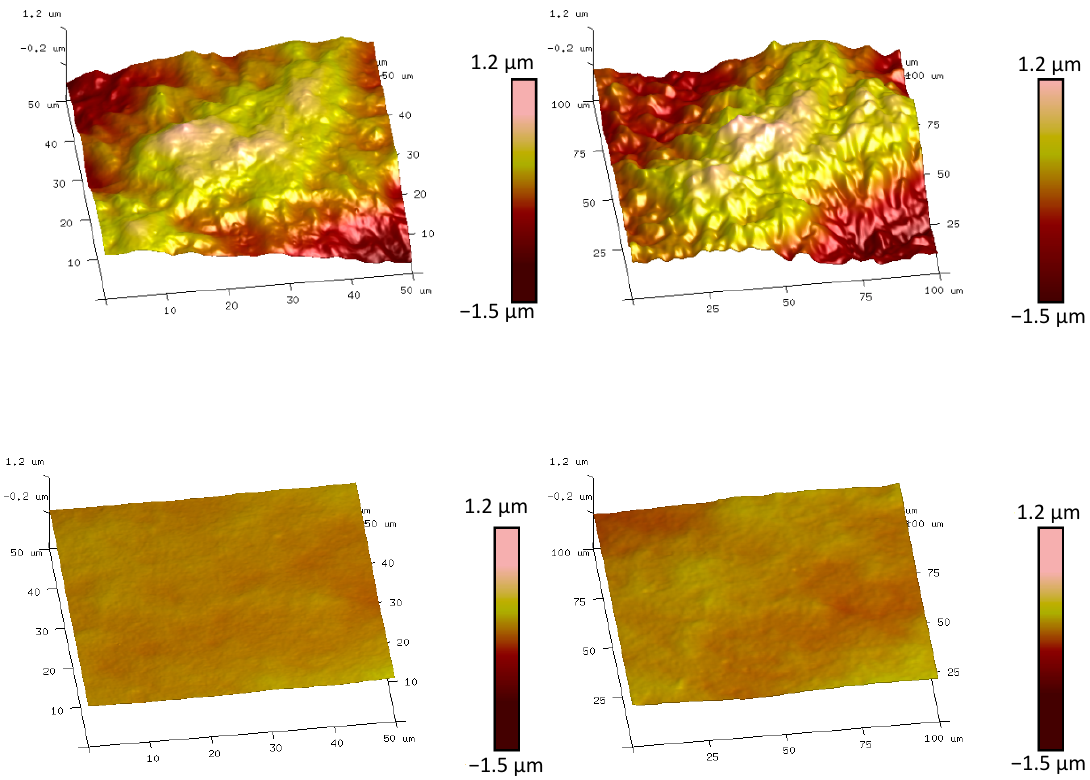
Figure 5. AFM ScanAsyst ® mode height images of PU2 and PU4 at 50 µ m × 50 µ m and 100 µ m × 100 µ m measurement lengths, respectively. Upper images are corresponding to PU2 and lower images to PU4 film.